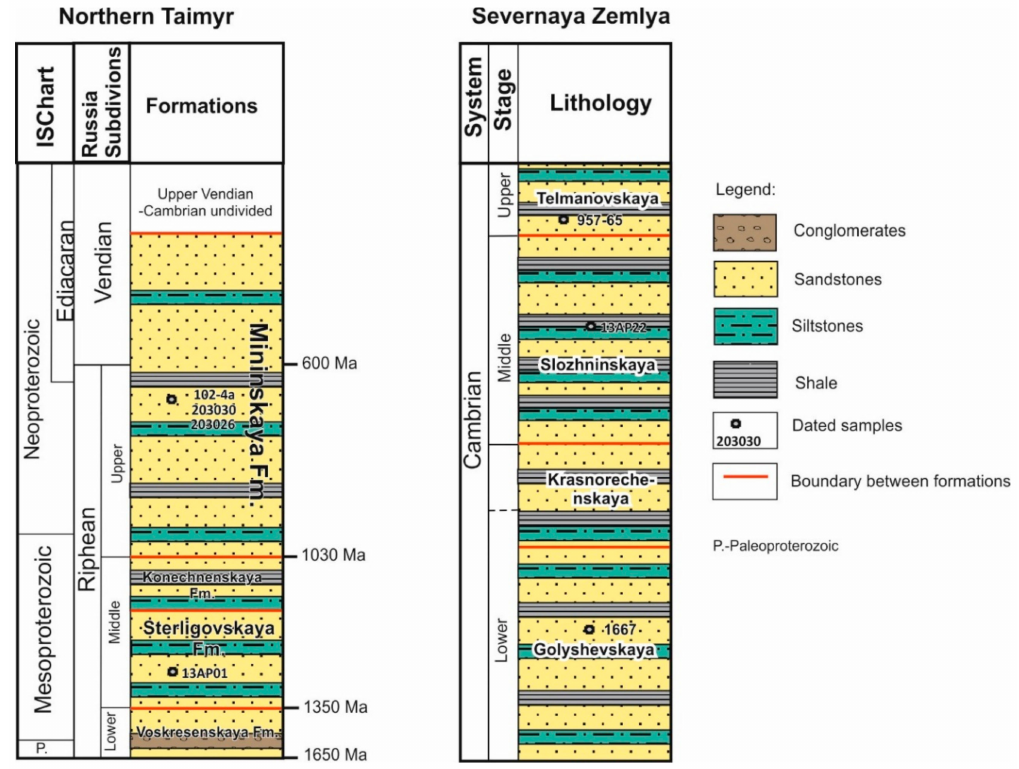
Figure 2. Generalized stratigraphic framework of Precambrian–Lower Paleozoic strata of Bol’shevik Island and northern Taimyr, based on [13–18]. Numerical ages from [21]. For the Mininskaya Formation, a Cambrian age has been proposed